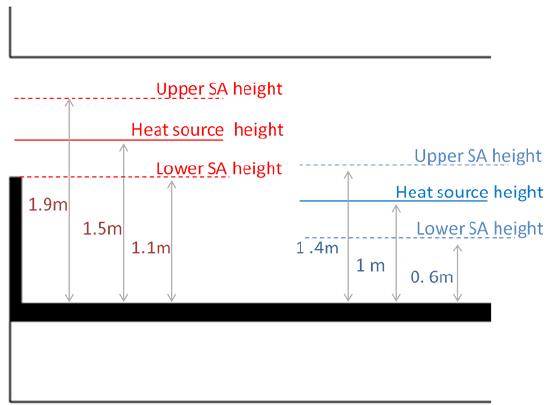
Figure 8. Heat source height settings.